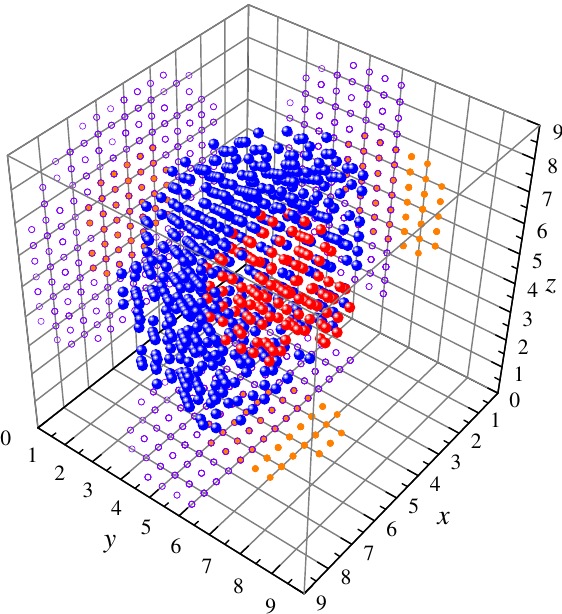
Figure 4. Data set “Hemisphere-sphere” has 618 samples, 3 features (coordinates x , y , z ), and 2 classes. Class c 1 has 499 points (blue dots) and class c 2 has 119 points (red dots). Point projections on to the xy , xz , and yz planes are drawn as circles (purple) for c 1 data and as small dots (orange) for c 2